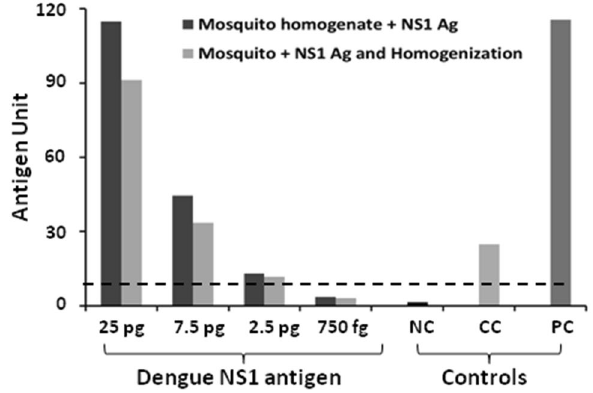
Figure 5. Detection of rDENV-2 NS1 antigen in Aedes aegypti mosquito pools. The mosquitoes were either homogenized with different concentrations of rDENV-2 NS1 or the antigen was added to homogenized mosquito samples and ELISA was performed. Antigen units were calculated as described earlier. NC Negative control, CC Calibrator control, PC Positive control.